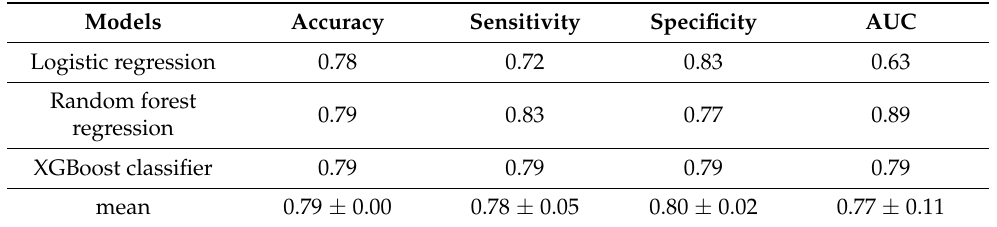
Table 3. Model performances for the predictive modeling.